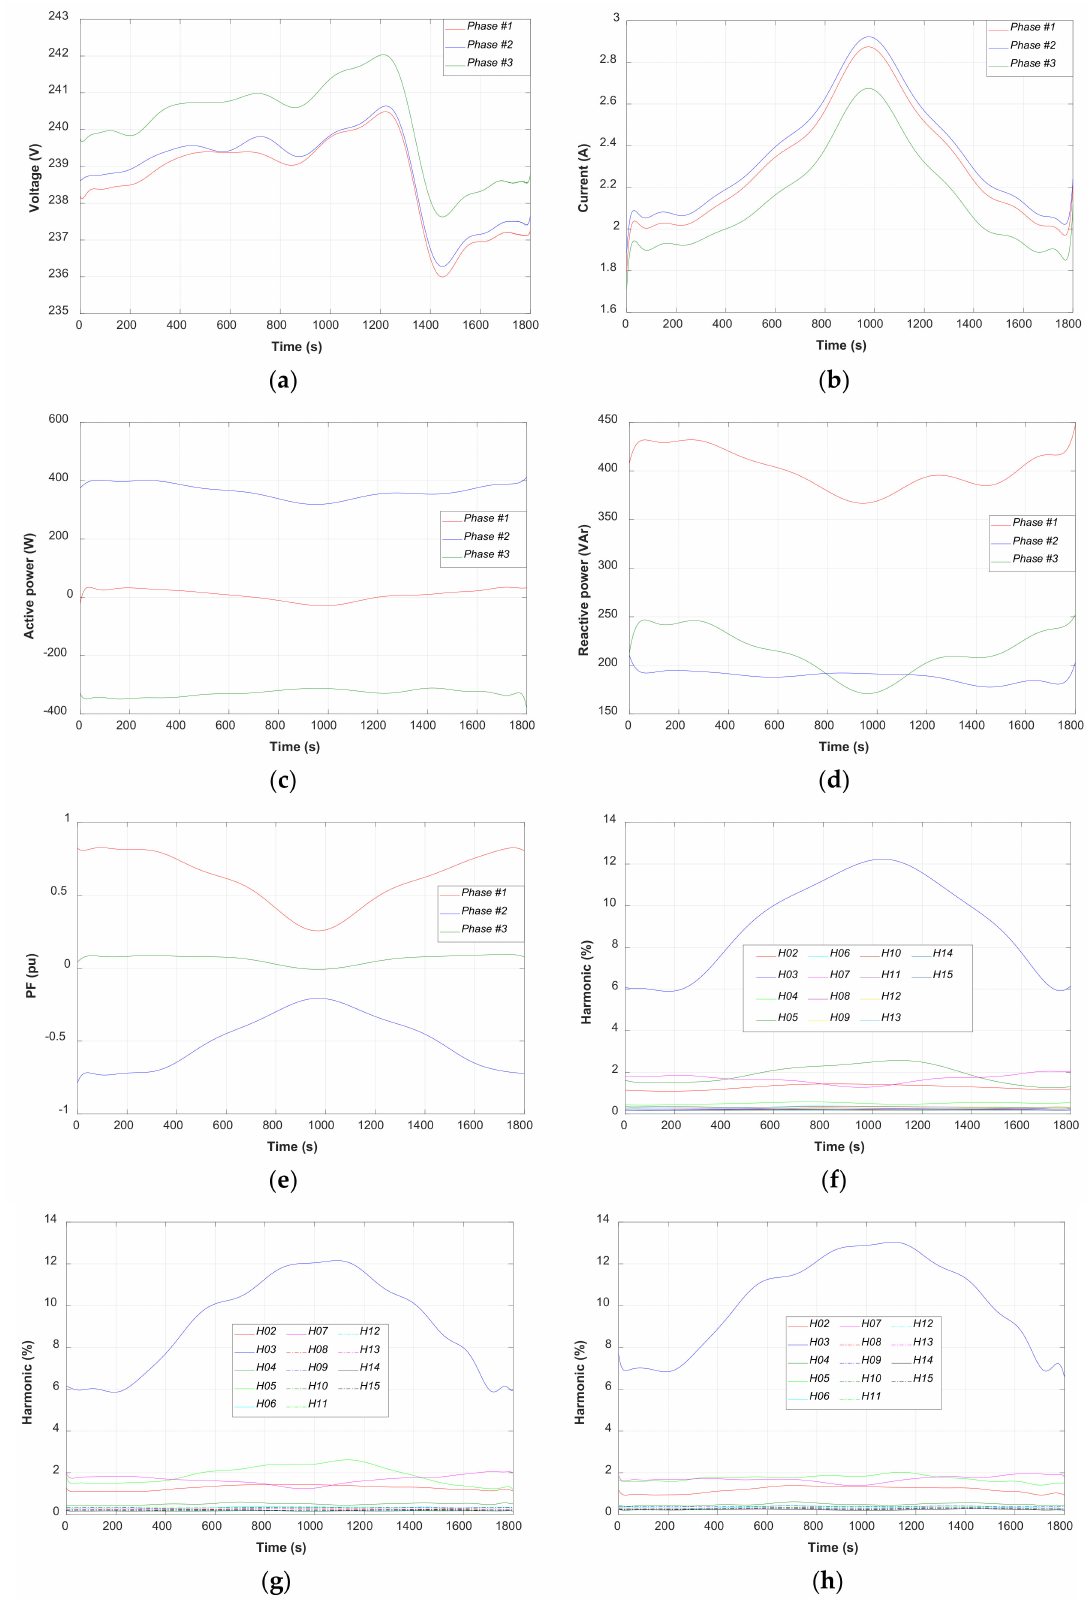
Figure 12. Measured data per phase for grid-coupled synchronous generator: ( a ) voltages; ( b ) currents; ( c ) active powers; ( d ) reactive powers; ( e ) power factor; ( f ) Phase #1 current harmonics; ( g ) Phase #2 current harmonics; and ( h ) Phase #3 current